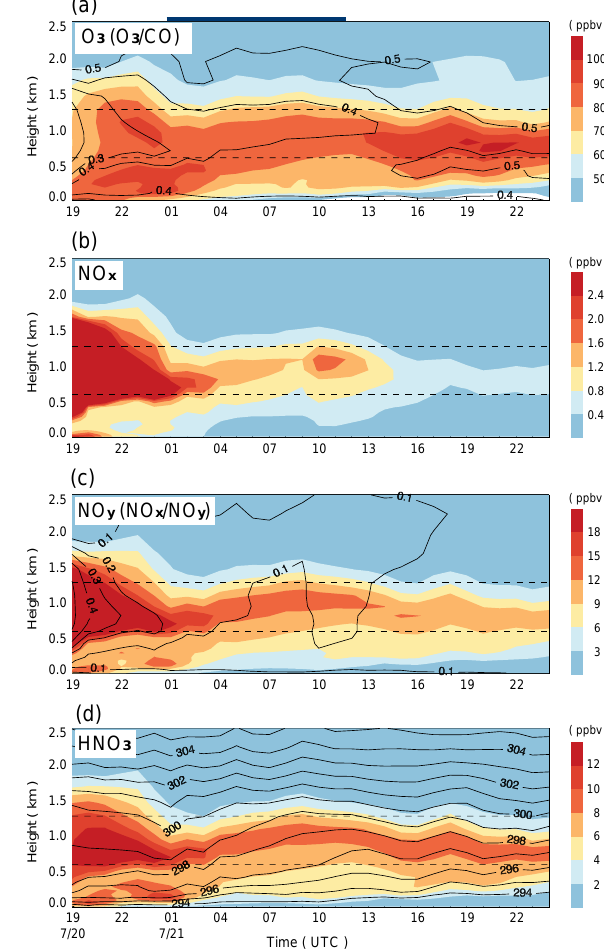
Fig. 13. Time-height plots of simulated (a) O 3 and O 3 /CO, (b) NO x , (c) NO y and NO x /NO y , and (d) HNO 3 and potential temper- ature along the forward trajectory of the upper-level NYC plumes (dashed lines) denoted in Fig. 11. Upper thick lines in (a) denote nighttime period. The upper-level NYC plumes were transported over the ocean during the full trajectory